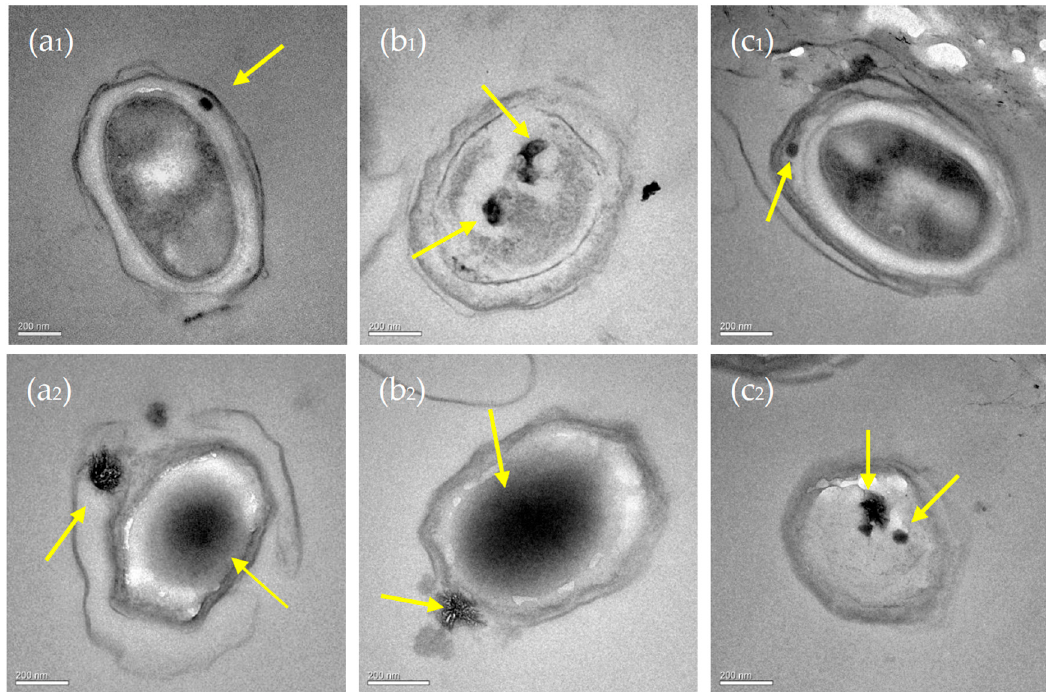
Figure 11. TEM images of ultrathin slices of LD532 bacterial cell after 30 days of culture: ( a 1 – c 1 ) TEM analyses of cells at an Mg/Ca ratio of 2 in MgSO 4 solution; and ( a 2 – c 2 ) TEM analyses of cells at an Mg/Ca ratio of 2 in MgCl 2 solution. The intracellular and extracellular minerals are marked with yellow arrows.